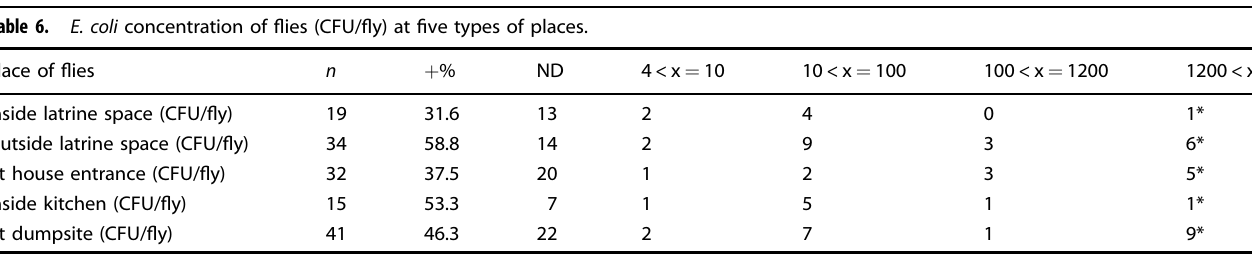
Table 5. Number of fl ies on each fl y trap ( fl ies/trap) at fi ve places. Place of fl y traps ( fl y no. unit) n Inside latrine space ( fl y no./trap) Outside latrine space ( fl y no./trap) At house entrance ( fl y no./trap) Inside kitchen ( fl y no./trap)